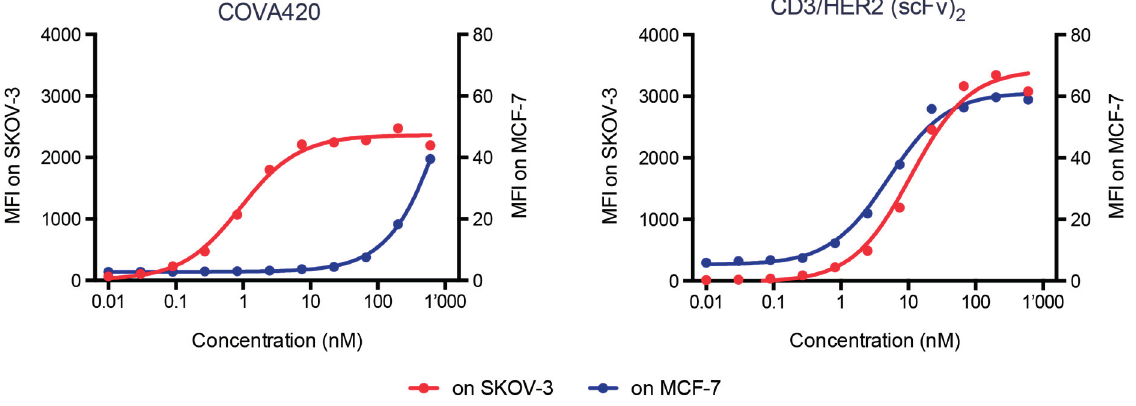
Figure 5. Flow cytometric binding analysis of COVA420 (left panel) and CD3/HER2 (scFv) 2 (right panel) on SKOV-3 cells (high expression, red line, left y-Axis) or MCF-7 cells (low HER2 expression, blue line, right y-Axis). For each cell line the scale was adjusted to the maximum level of binding observed. EC 50 of COVA420 were 0.9 nM on SKOV-3 cells and >200 nM on MCF-7 cells, EC 50 of CD3/HER2 (scFv) 2 was 11 nM on SKOV-3 and 5 nM on MCF-7